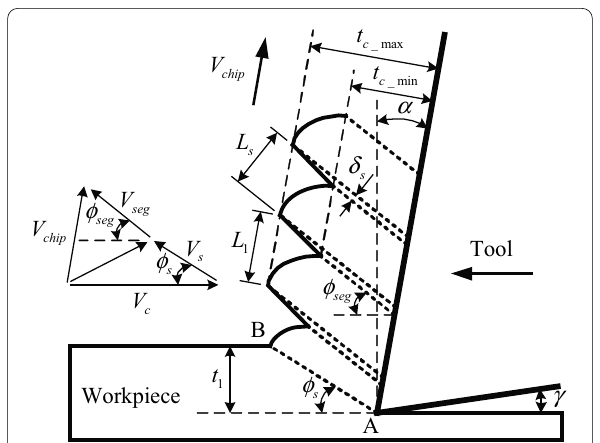
Figure 5 Schematic diagram of shear localized bands and the serrated chip formation (neighboring shear bands spacing L s , serrated chip pitch L 1 , segment inclination angle φ seg , shear planes velocities V s and